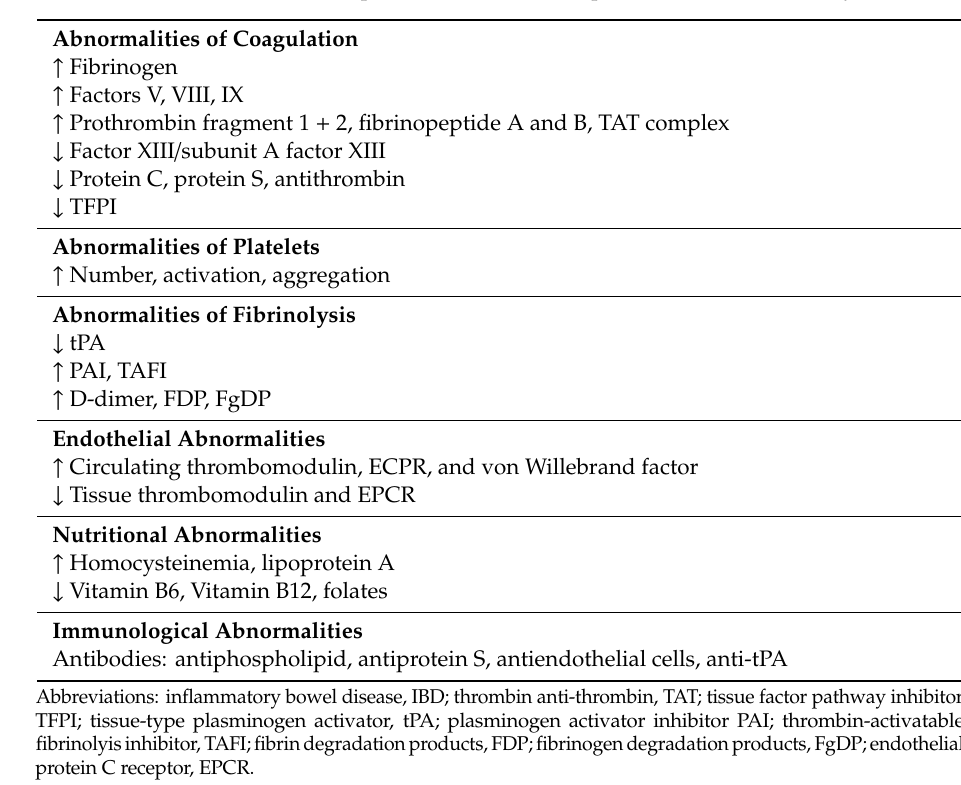
Table 2. Abnormalities of hemostatic parameters observed in patients with inflammatory bowel